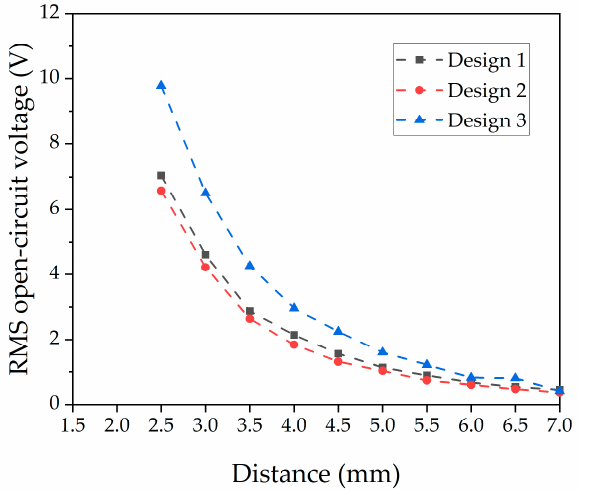
Figure 16. Open-circuit voltage of the three harvester designs simulated at varying the distance d between the magnets.